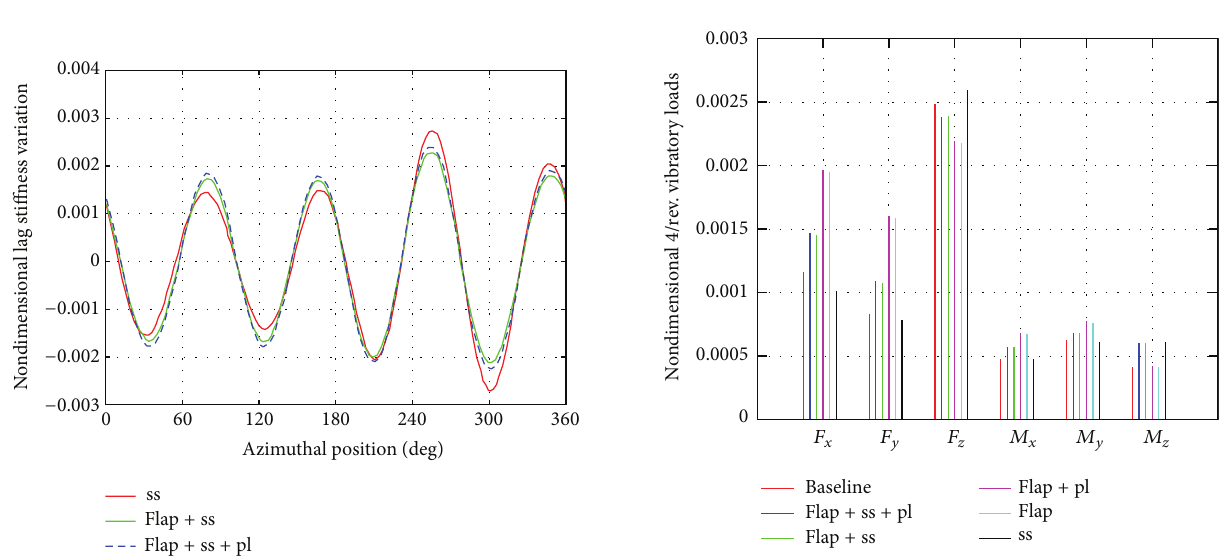
Figure 5: Flap bending stiffness time history.